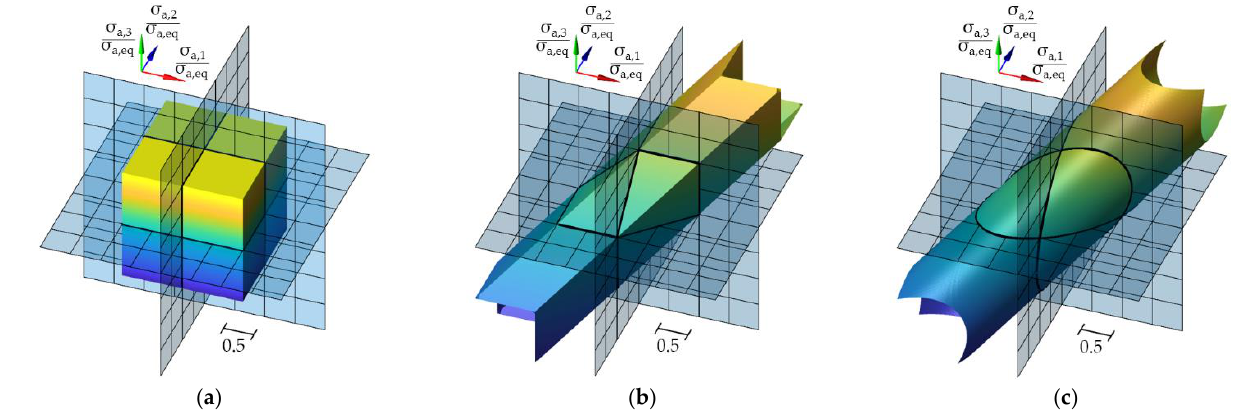
Figure 2. Visualization of the established strength hypotheses according to ( a ) Rankine, ( b ) Tresca, and ( c ) von Mises for proportional loading as principal stress diagrams for triaxial stress states.